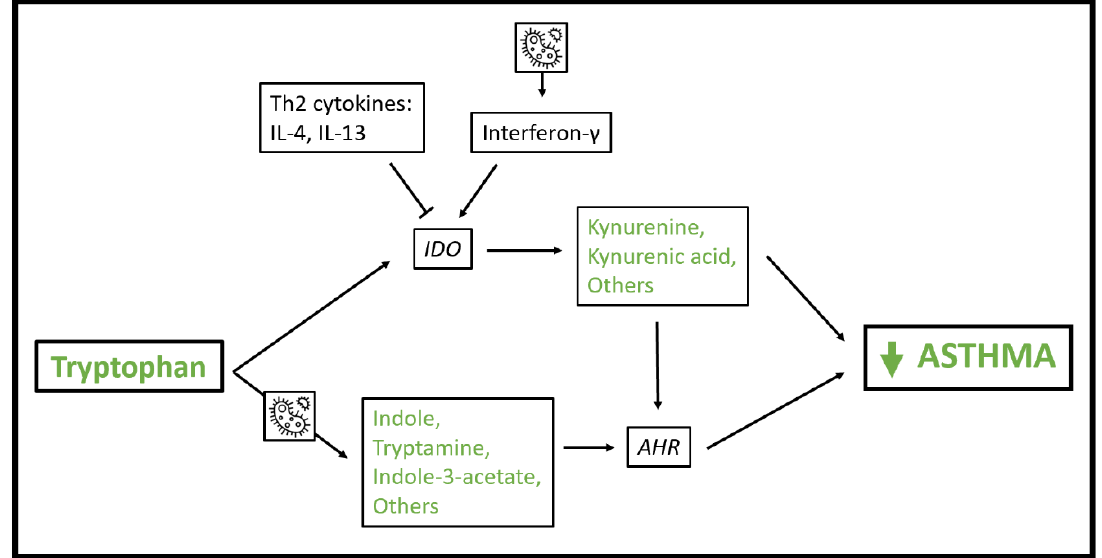
Figure 2. Schematic of mechanisms whereby tryptophan metabolic pathways influence asthma pathophysiology. As indicated by the microbe icon, microbial exposure induces interferon- γ production, and gut bacteria participate in metabolism of tryptophan to indole, tryptamine and other metabolites with activity at the aryl hydrocarbon receptor. Abbreviations: AHR = aryl hydrocarbon receptor; IDO = Indoleamine